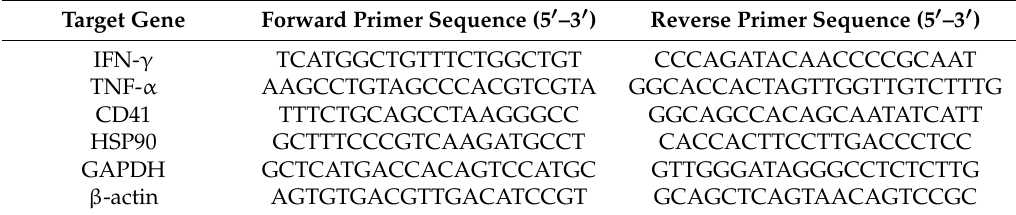
Table 1. Target genes and their primer